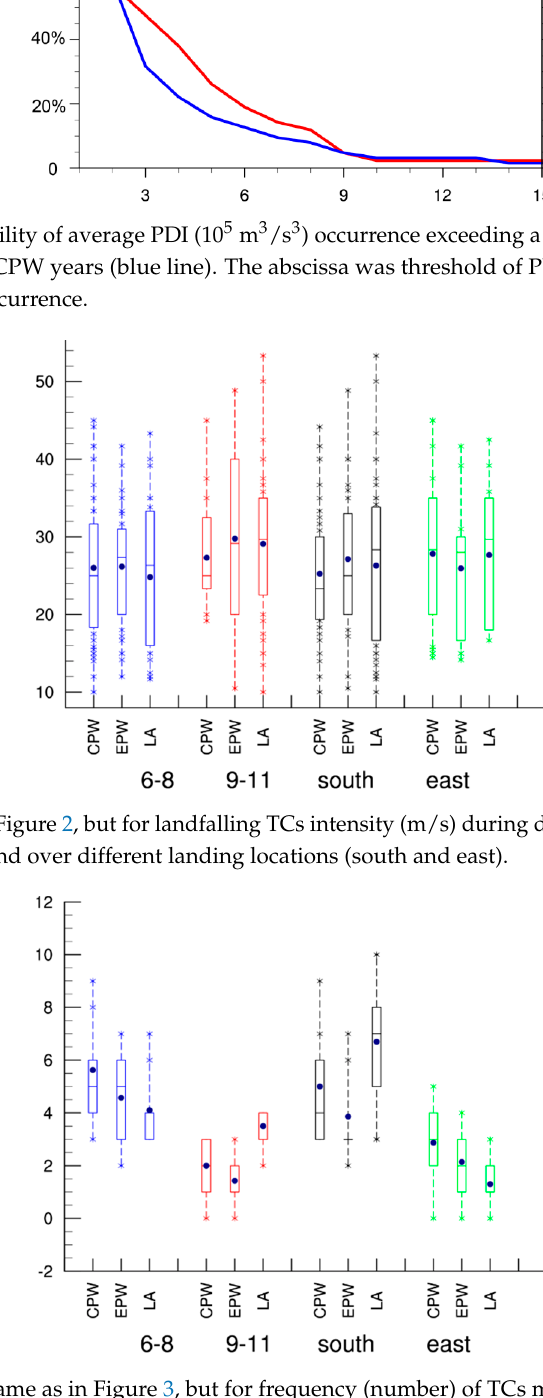
Figure 6. Same as in Figure 3, but for TC duration (h) after landfall.